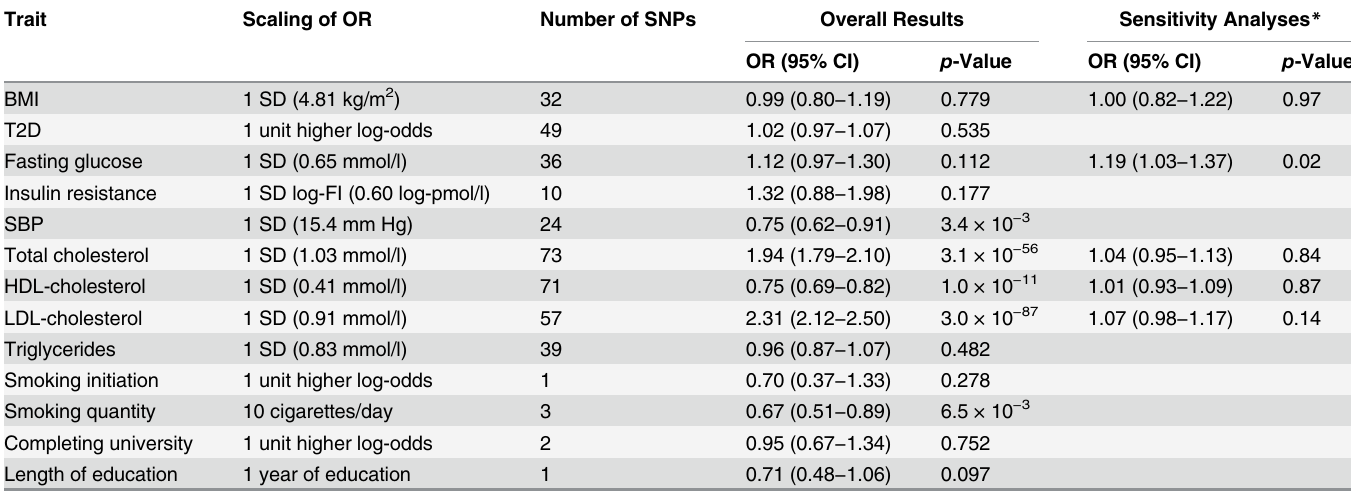
Table 1. Estimated associations of each genetically predicted risk factor with Alzheimer